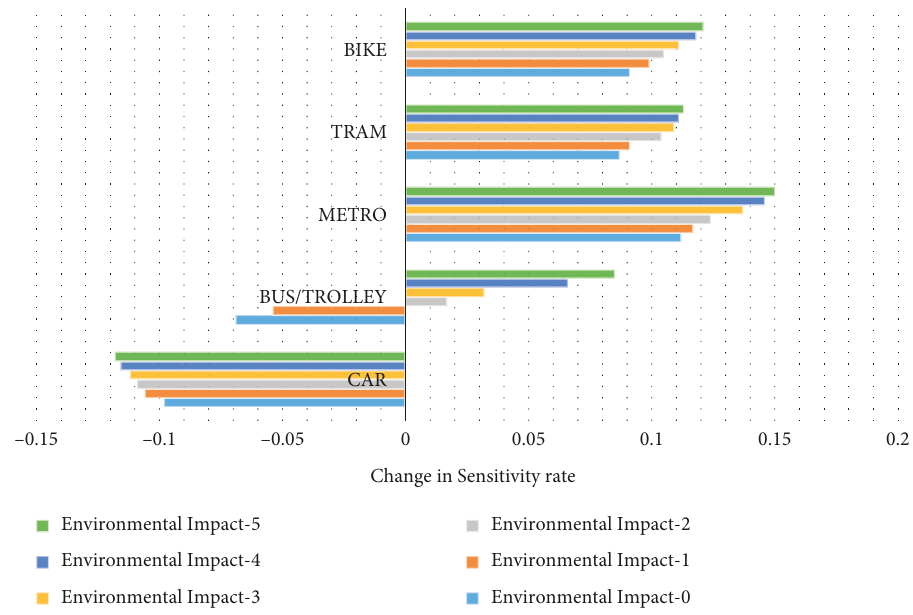
Figure 11: The values of the coefficients based on the changes in the environmental impact.